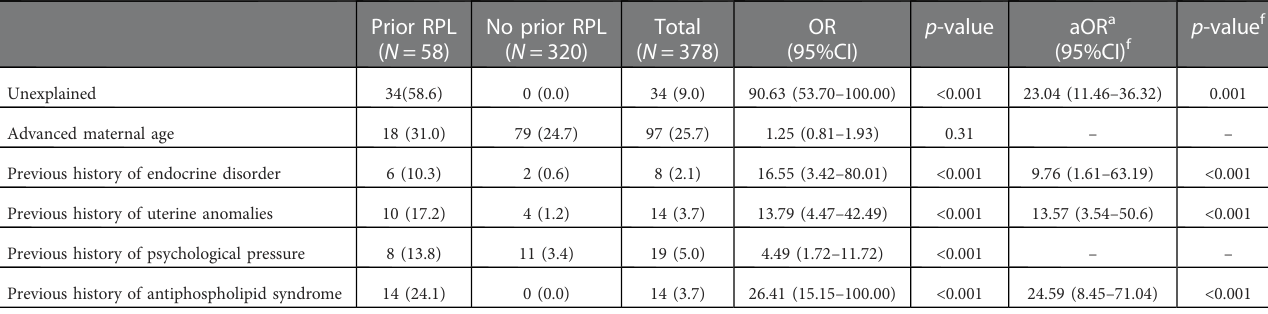
TABLE 2 Bi-variable and multivariable logistic regression of risk factors for RPL in the whole participants.